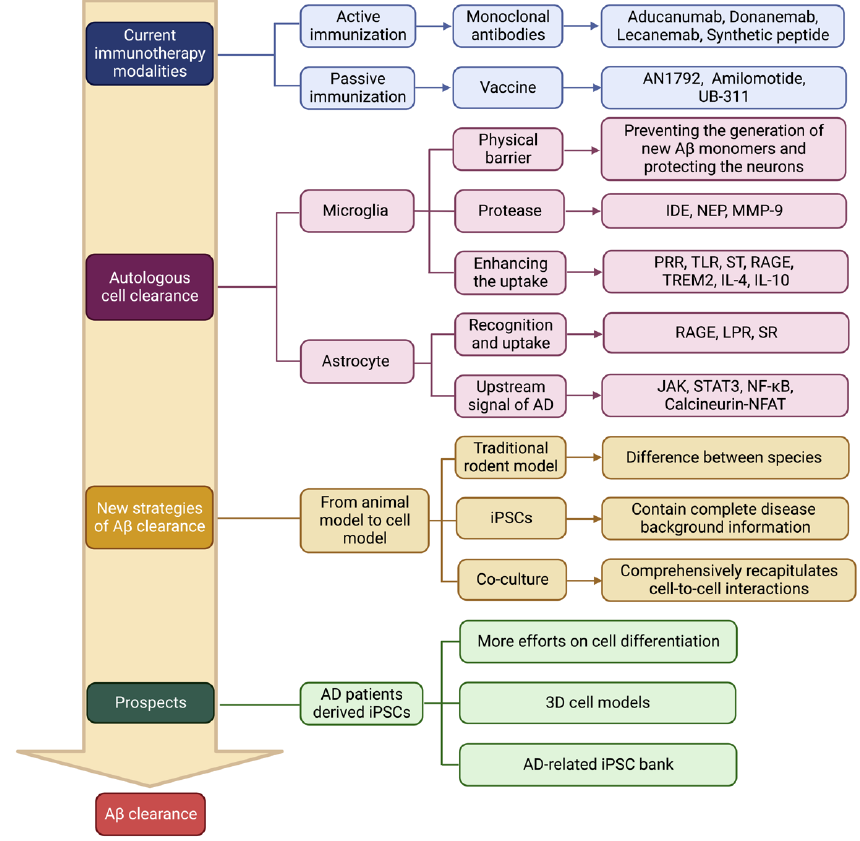
Figure 4. The s ummary of Aβ clearance from drugs or cell models in current studies. Figure 4. The summary of A β clearance from drugs or cell models in current